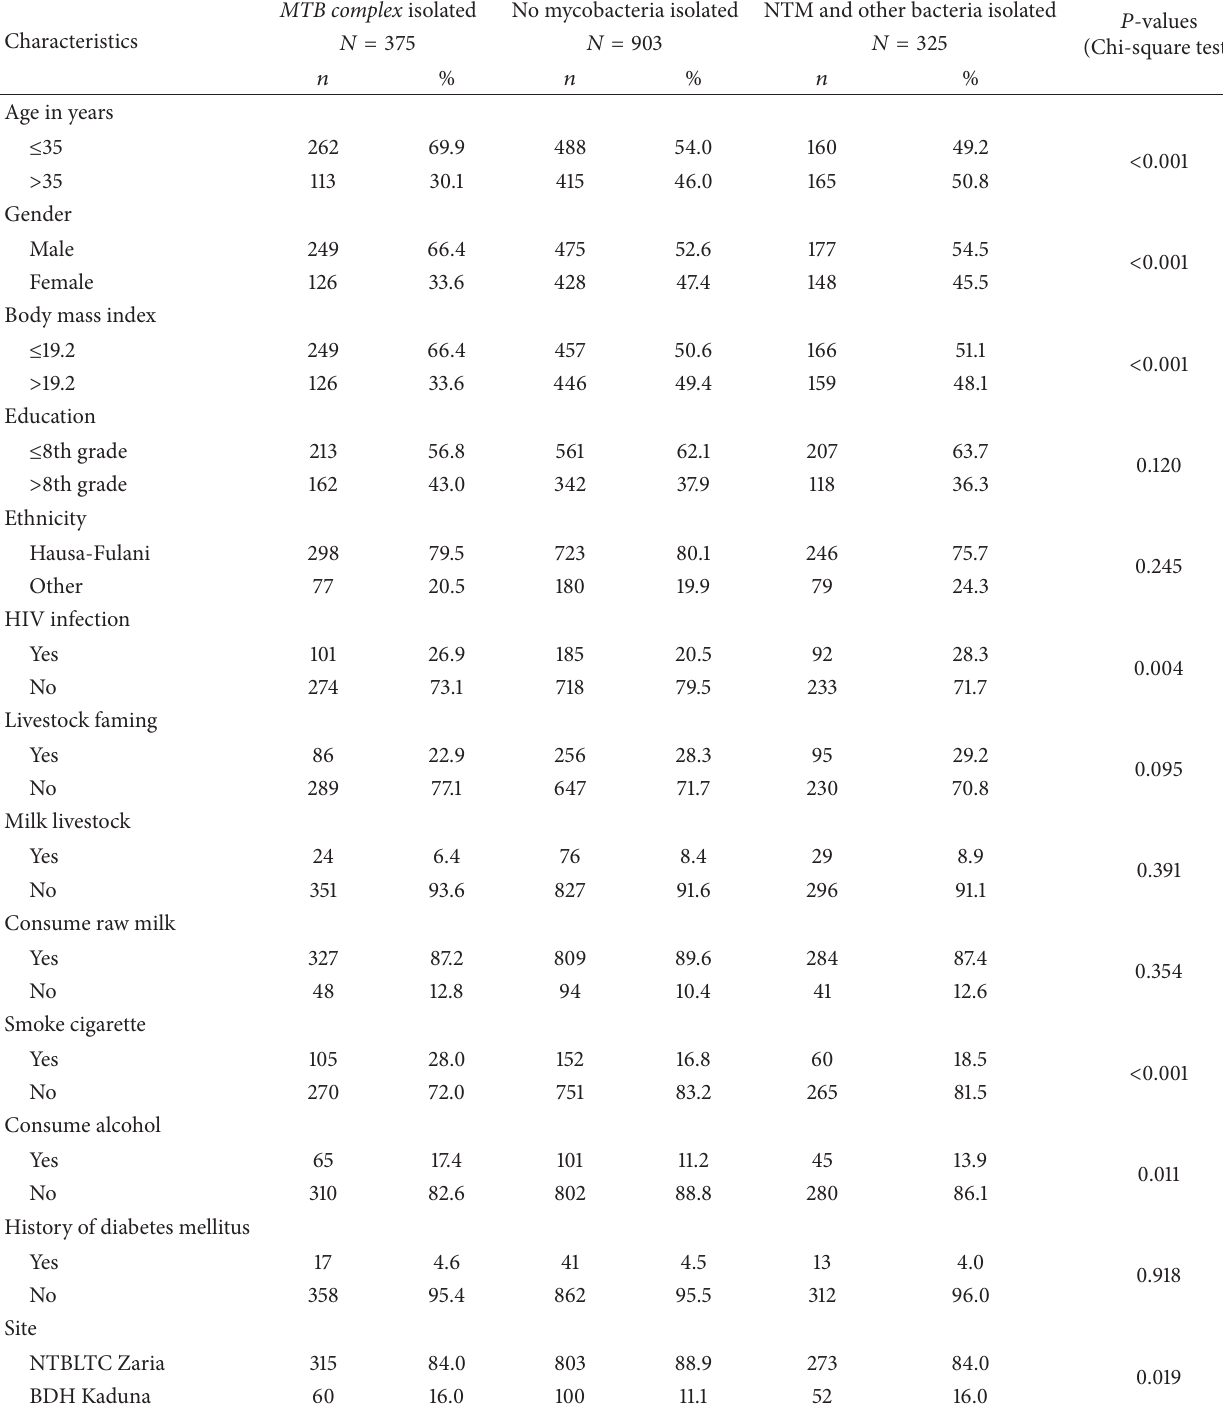
Table 1: Demographic characteristics and risk factors for infection with species of Mycobacterium tuberculosis complex among participants receiving care at two TB treatment sites in northern